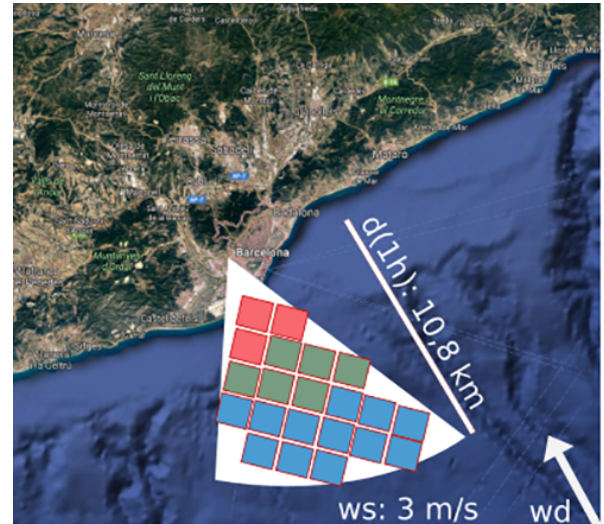
Figure 3. Scatter plot showing daylight mean O x and NO x relation of the difference between Eixample and Ciutadella stations from the beginning of October to the end of February for the years 2012 to 2016.